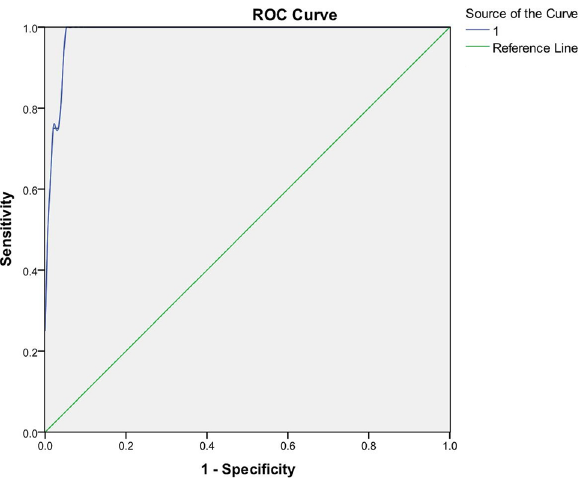
Figure 2. Receiver operator characteristic (ROC) Curve for cut-off analysis of concentration of bacteria value in patients with AL.